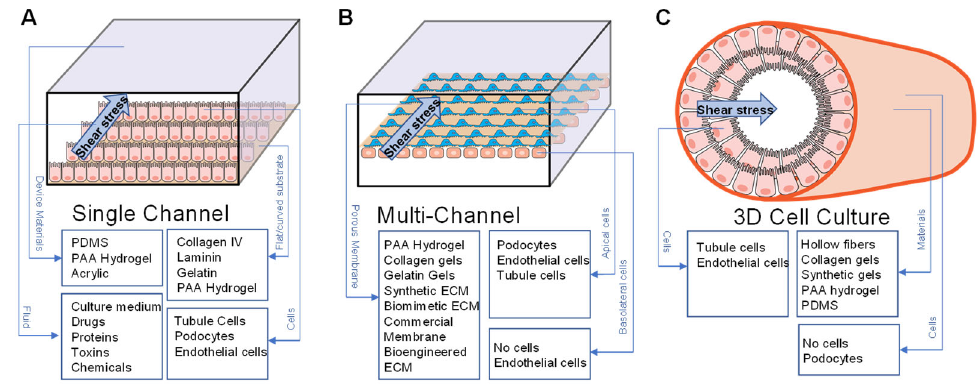
Figure 3. Shear stress applied to kidney ‐ on ‐ a ‐ chip. Schematic drawing of the design for single ‐ channel, multi ‐ channel, and 3D cell culture devices. ( A ) A single channel is coated with collagen or laminin ECM, gelatin, or PAA hydrogel for cell attachment. Renal tubule cells, podocytes, or endothelial cells cultured on a thin layer of ECM. Cells are supplied with culture media and reagents for drug screening, toxicity evaluation, or interrogation of different cell functions. ( B ) Multi ‐ channel device is composed of apical and basal channels with continuous media supply. Shear stress can be applied to each channel. Cell monolayer or co ‐ cultured cells are supported by a bioengineered, synthetic, or commercially available porous membrane. ( C ) 3D cell culture device is composed of hollow fibers, 3D printed gels, or PDMS.